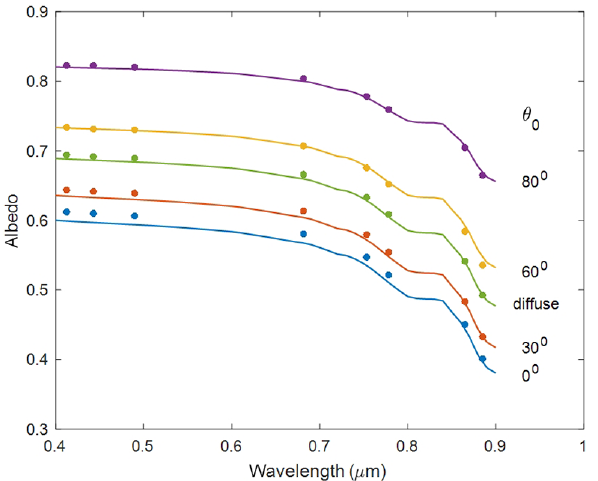
Figure 7. Spectral albedo of the same layer at different incidence (direct and diffuse), calculated with the RAY code (dots) and the asymptotic formulas